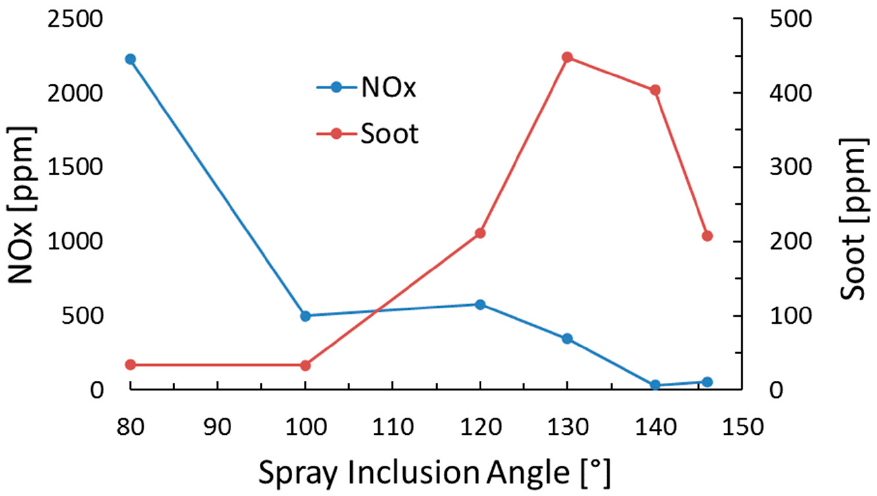
Figure 39. NO x and soot emission characteristics of various SIAs. Engine-out CO emissions, according to SIA, are presented in Figure 40. For the wide SIAs, incomplete combustion near wetted cylinder walls causes higher CO emissions [67]. For ESI, if spray is targeted at the stepped lip of the piston bowl by reducing SIA, the combustion of more uniform lean FVAM filling the piston bowl and the squish region results in the lowest CO emissions. Finally, in the narrowest SIA cases, high-temperature combustion in the piston bowl promotes complete combustion. However, minor CO emissions occur due to local oxygen